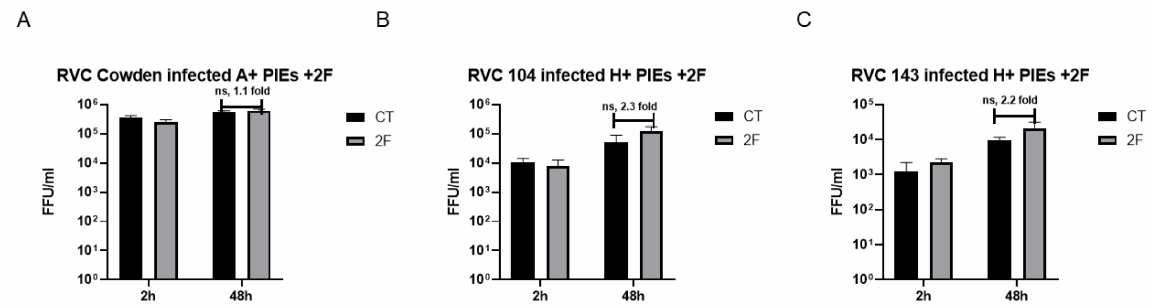
Figure 2. RVC replication in PIEs with or without 2F treatment. An amount of 500 µ M 2F or CT (DMSO) was added to differentiate HBGA-A+ and HBGA-H+ PIEs for 3 days (media with 2F/DMSO were refreshed every day), and then infect them with RVC strains, followed by incubation for 2 days. Then, 2F-treated PIEs were used for RT-PCR detection of ( A ) PRVC Cowden, ( B ) PRVC104, and ( C ) PRVC143 in A+, H+, and H+ PIEs, respectively. RVC titers were examined at 2 h and 48 h. The error bars represent the standard deviation from triplicate samples. All experiments were repeated independently at least 2 times. ns denotes no significant difference. Capped lines indicate the fold-changes between two groups.